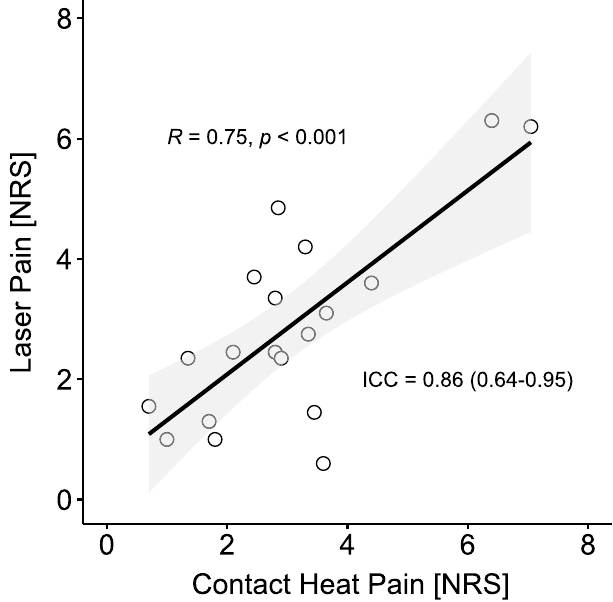
Figure 2. Perceived pain matching. Illustrated is the correlation between the contact heat (x-axis) and laser (y-axis) perceived pain as well as the intraclass correlation coefficient (ICC).